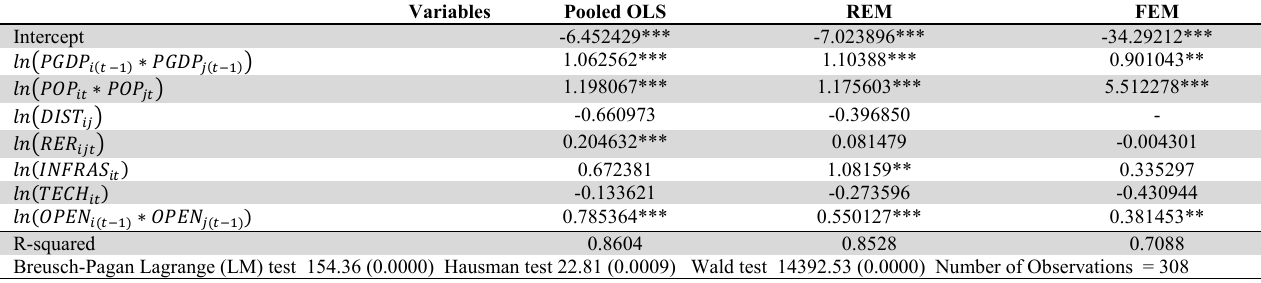
The results of estimation